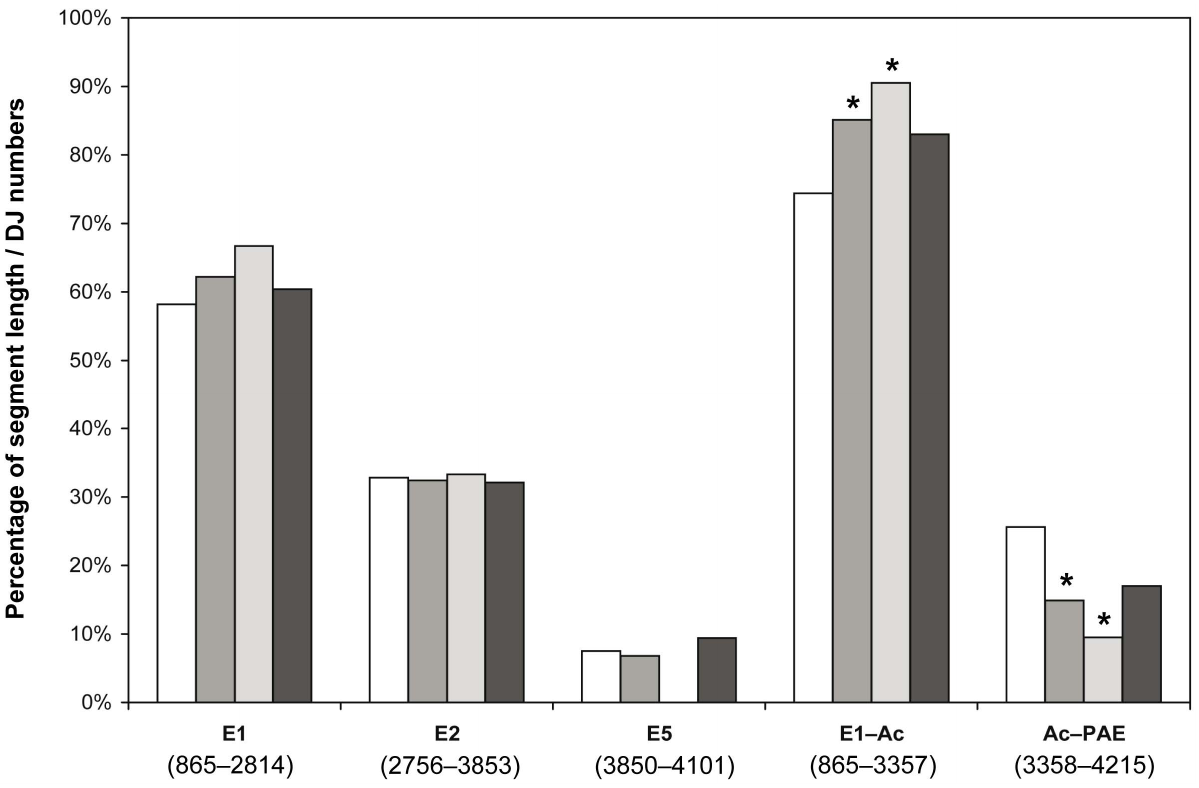
Figure 4. Frequency distribution of HPV16 3 9 -breakpoints in different segments of the HPV16 early region. The distribution of HPV16 3 9 -breakpoints of viral-cellular DNA junctions (n=74) was analyzed within the five different segments E1, E2, E5, E1-Ac and Ac-PAE of the HPV16 early region. The positions of each segment in the HPV16 genome are given in parentheses. The E1-PAE segment of the HPV16 early region (pos. 865– 4215, 3351 bp) was taken as reference. The relative length of each segment is shown by the white bars. The relative frequency of HPV16 3 9 - breakpoints within each segment is shown by the grey bars for all DNA junctions (DJ_all, n=74, middle-grey bar), the transcribed DNA junctions (DJ_tr., n=21, light-grey bar) and the non-transcribed DNA junctions (DJ_n.tr., n=53, dark-grey bar). The exact two-tailed one-sample binomial test was used for statistical analysis by comparing the relative frequency of HPV16 3 9 -breakpoints in each segment to the relative segment length. Bars marked with asterisks indicate statistically significant results (P , 0.05). Data are given in Table S4.